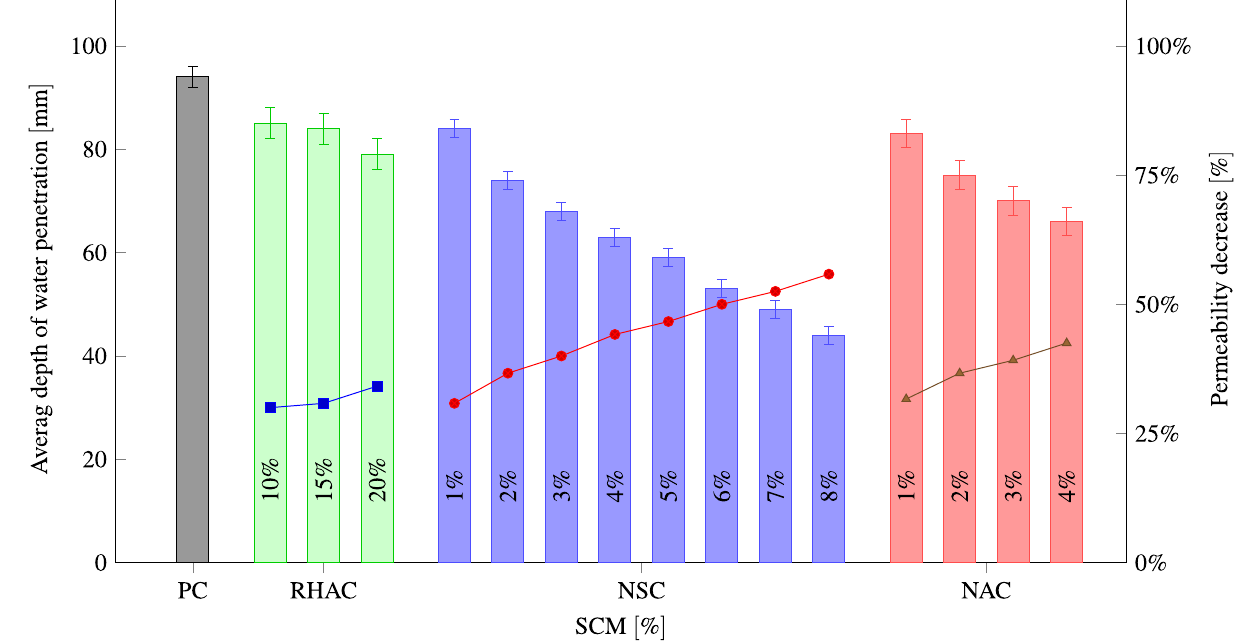
Figure 10. Average depth of water penetration at 28 days for different percentages of RHA, NS, NA replacement.